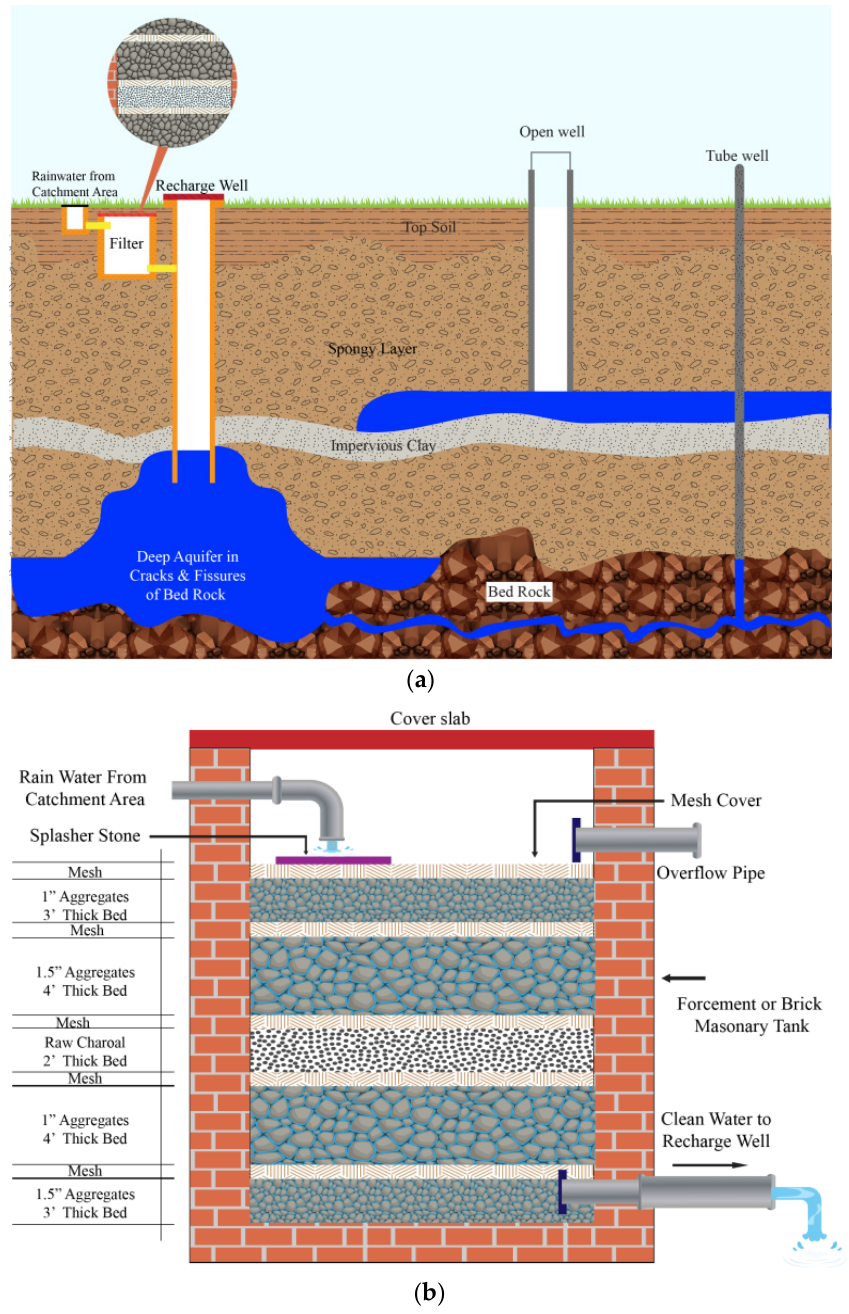
Figure 5. ( a ) Groundwater level rises by recharge well, and ( b ) Schematic diagram of filter. Table 1. Typical ranges of permeability coefficients for different soil types [45]. Sr. No